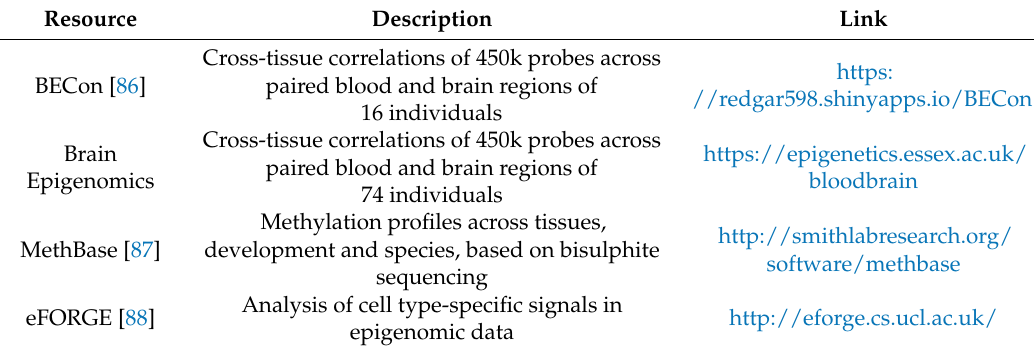
Table 6. Resources for cross-tissue comparisons of methylation